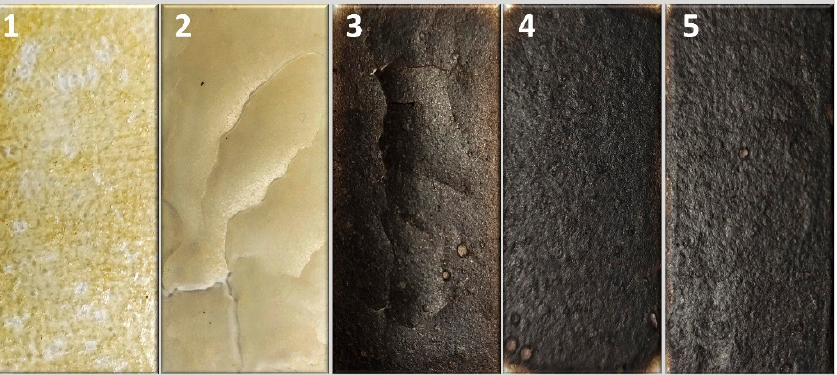
Figure 6. Adhesive cracks 1: SPI adhesives, 2: SPI/PAE adhesives, 3: SPI/PAE/0.2% FGO adhesives, 4: SPI/PAE/0.4% FGO adhesives, and 5: SPI/PAE/0.6% FGO adhesives. 4: SPI/PAE/0.4% FGO adhesives, and 5: SPI/PAE/0.6% FGO